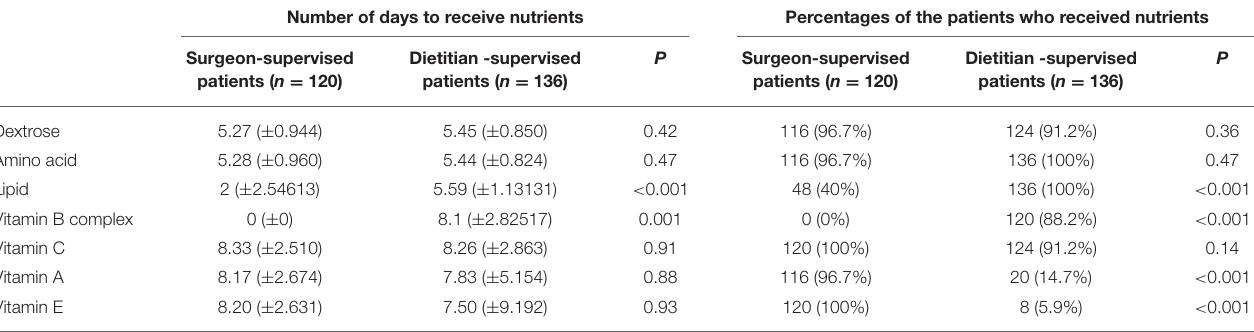
TABLE 3 | Comparison of Clinical outcomes of two groups at baseline and after parenteral nutrition. Surgeon-supervised patients ( n = 120) Dietitian -supervised patients ( n = 136) Mean ( ± SD) at baseline Mean (SD) after PN Mean difference P Mean (SD) at baseline Mean (SD) after PN Mean